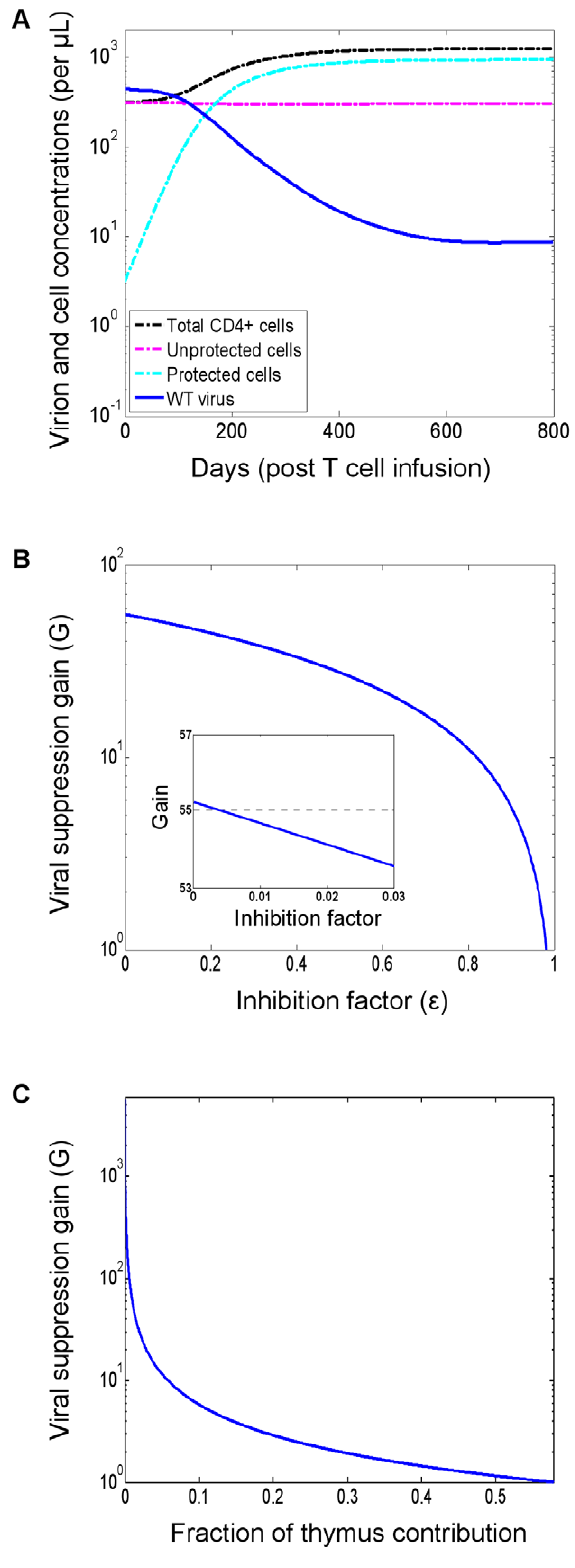
Figure 2. Infection dynamics under gene therapy and the dependence of the viral suppression gain on the inhibition factor and on the thymus contribution. (A) Dynamics in the absence of viral resistance. Simulations were performed with